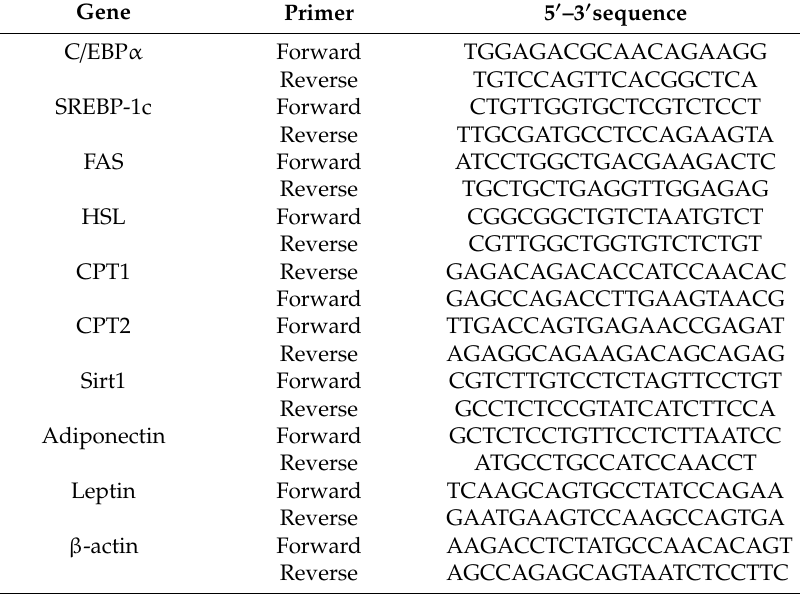
Table 1. Primers used for real-time PCR analysis of genes. Gene Primer 5 (cid:48) –3 (cid:48)